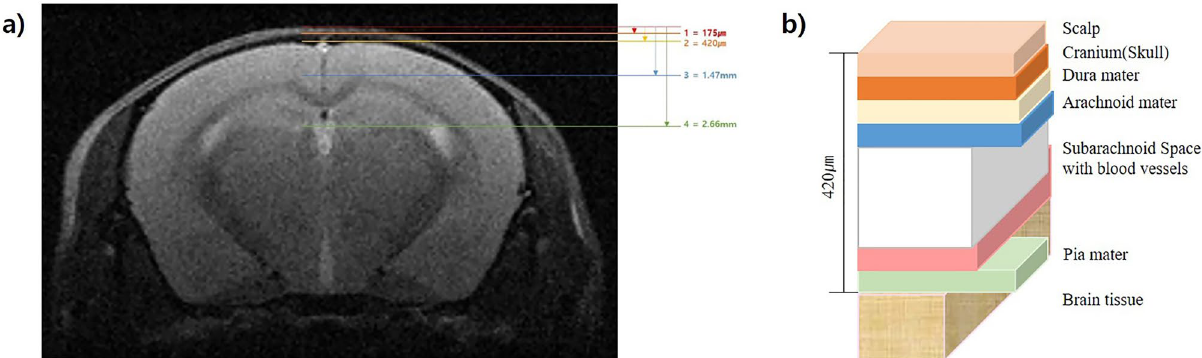
Figure 9. Murine head structure analysis and simulation model construction: ( a ) brain MRI images of C57BL/6 mice; ( b ) analytical model of different layers (scalp, skull, dura matter, arachnoid matter, subarachnoid space, pia matter, brain) of the murine head.